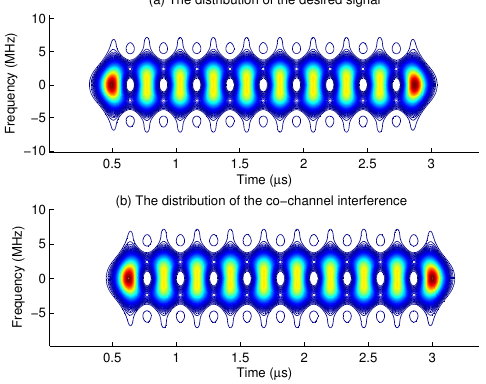
Figure 14. Time frequency distributions of the desired and co-channel interference signals. The simulation parameters are listed in Table